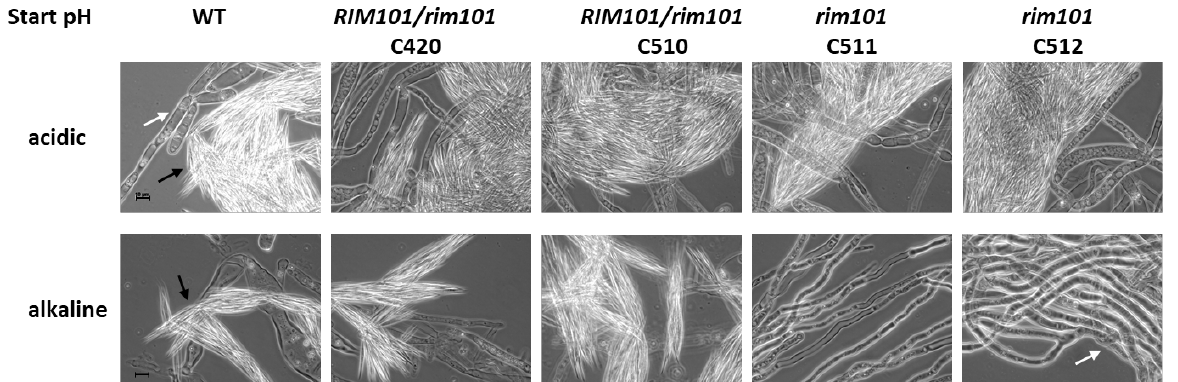
Figure 5. Liquid sporulation assays at acidic and alkaline pH. The indicated strains were pre-grown in AFM and then transferred to CSM-sporulation media (acidic = unbuffered with a starting pH of 5.3; alkaline = Tris-buffered to a pH of 8.6 at room temperature). After one week of incubation at 28 °C, samples were analyzed by microscopy. Representative images are shown. Clumps of spores (indicated by black arrows in the WT) were abundant in sporulating strains but completely absent in homokaryotic rim101 mutants showing only hyphal filaments (indicated by white arrows). Scale bars are 10 µ